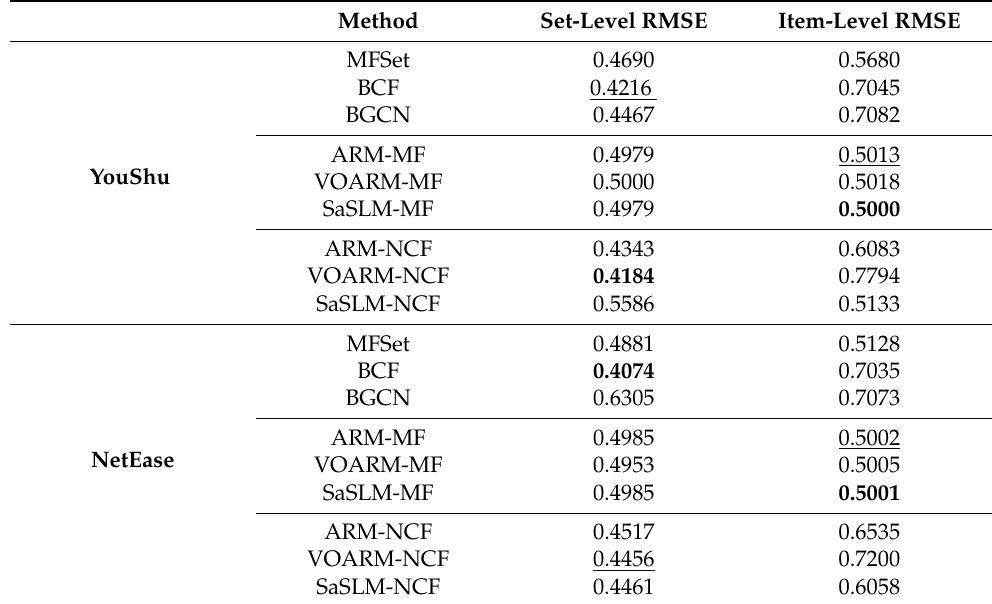
Table 5. Performance of set-rating prediction with sets of various